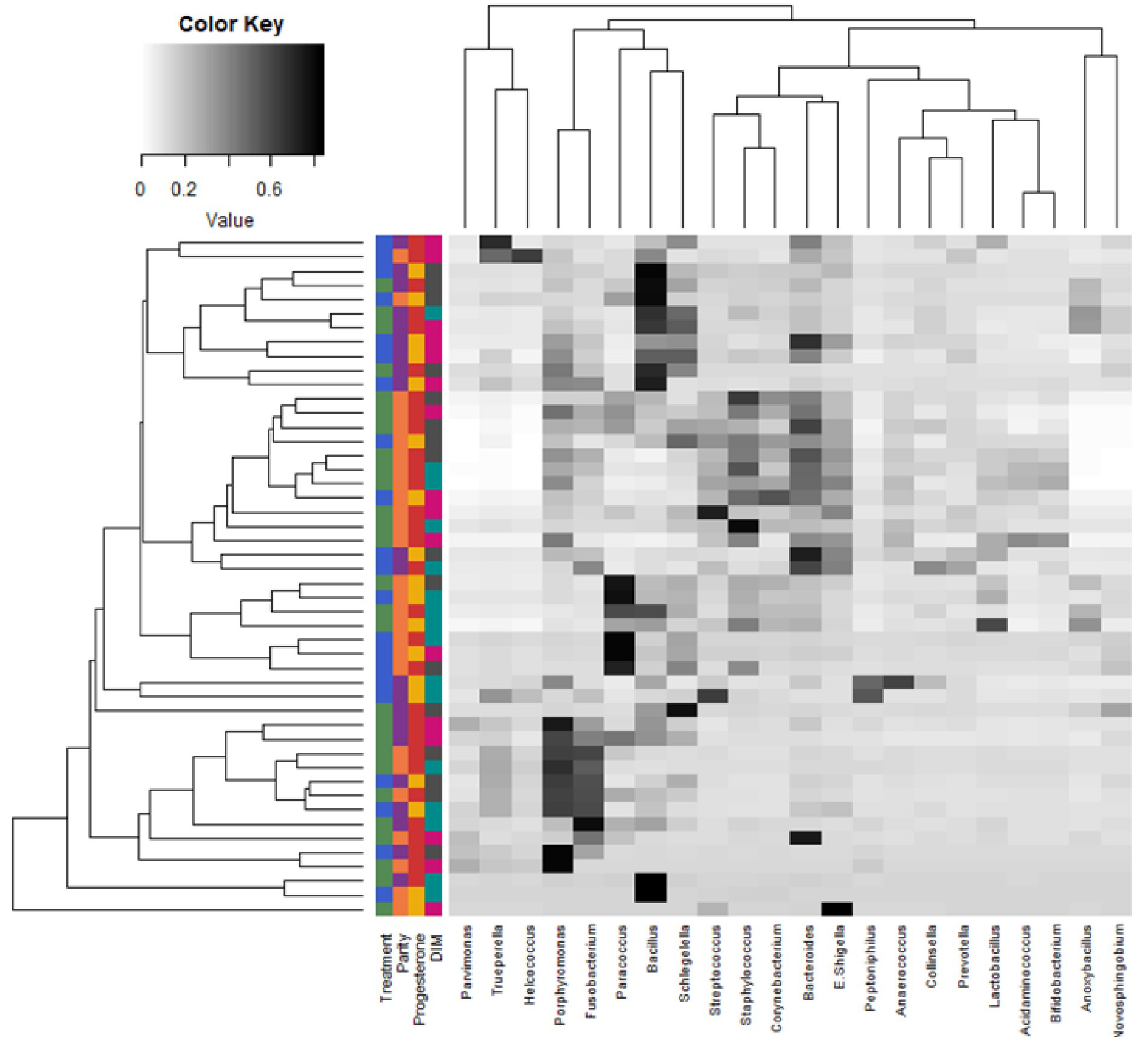
Fig 7. Heatmap with average linkage clustering based on Bray–Curtis distance showing the relative abundances of the most influential uterine bacteria genera in clinically healthy postpartum dairy cows (n = 16) in samples collected at 10, 21, and 35 d in milk (DIM). The relative abundance is indicated by a gradient of color from black (high abundance) to white (low abundance). Similarity dendrogram shows the unweighted pair group method with arithmetic mean (UPGMA) clustering of bacterial genera by treatment (n = 9, control (green) and n = 7, meloxicam (blue)), parity (n = 7, primiparous (purple) and n = 9, multiparous (orange), blood progesterone concentration at 35 DIM (n = 10, > 1 ng/mL (red) and n = 6, � 1 ng/mL (yellow)), and DIM (10 DIM (pink), 21 DIM (turquoise), and 35 DIM (dark